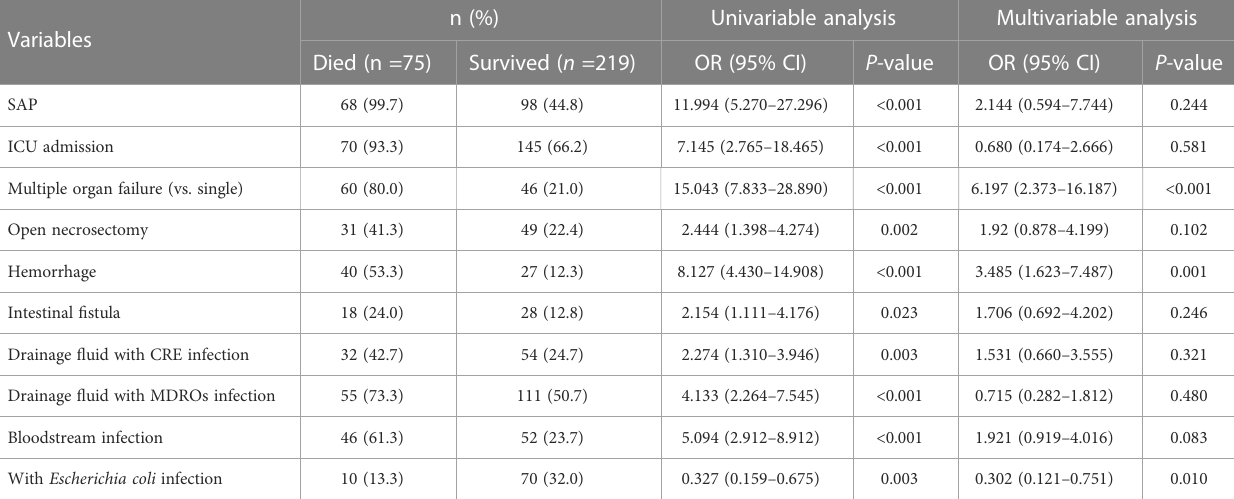
TABLE 3 Predictors of mortality in patients with